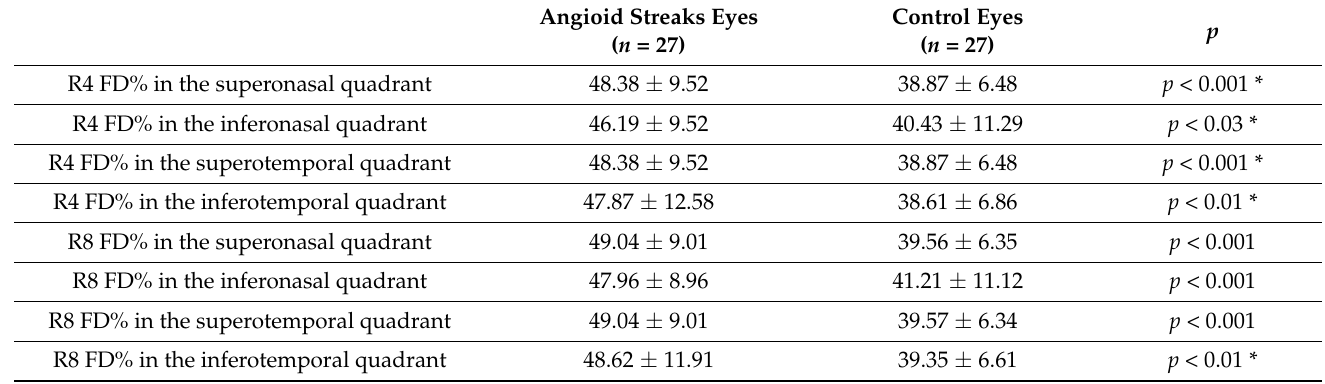
Table 2. Choriocapillaris Quantitative Study of the Peripheral 1 × 1 mm squares applying the Phansalkar local thresholding method: comparisons between angioid streaks eyes and control eyes. Angioid Streaks